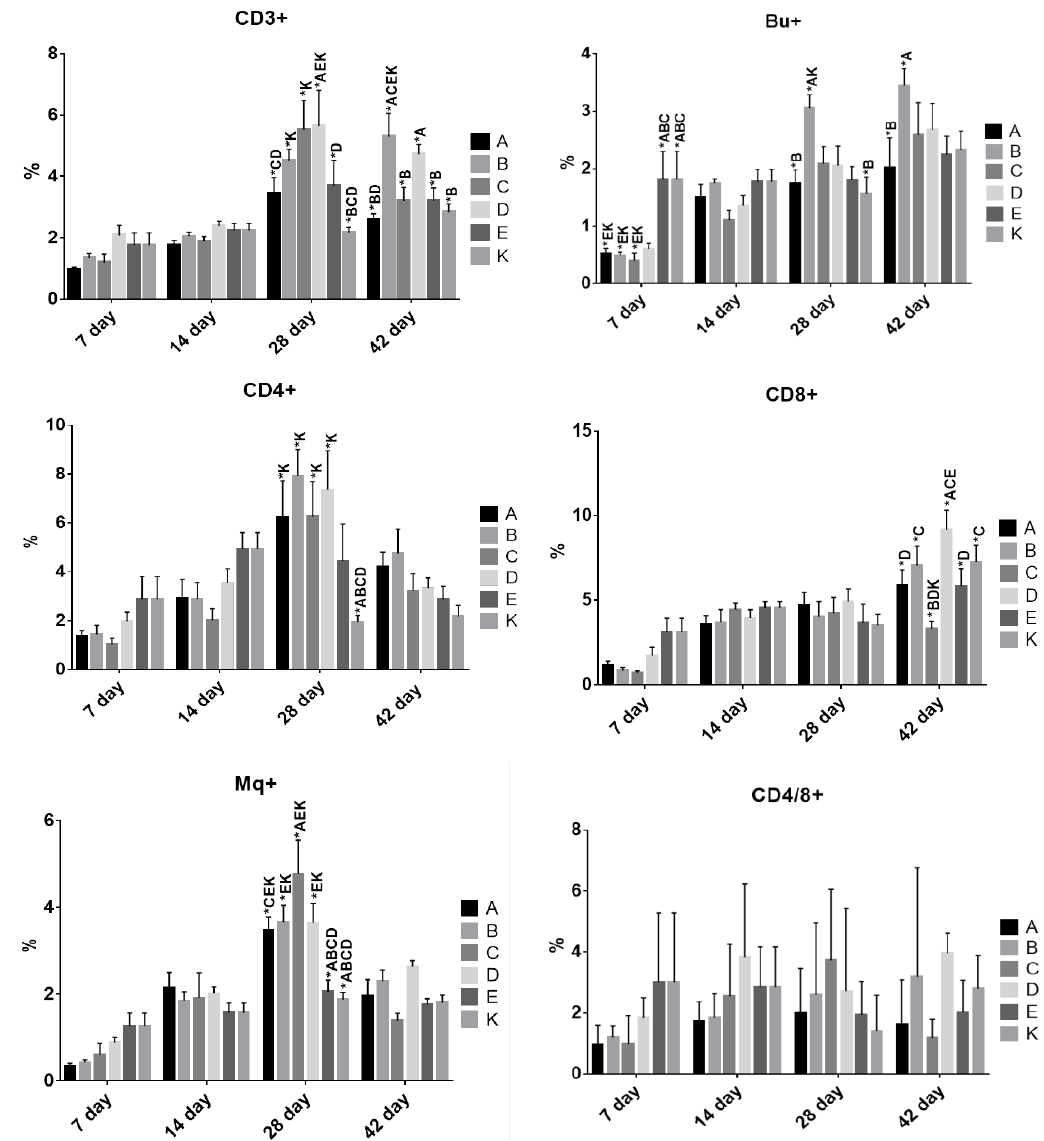
Figure 2. Flow cytometry analysis of the percentage of T lymphocytes with CD3 + , CD4 + , CD8 + , CD4 + /8 + receptors, B lymphocytes (Bu-1 + ) and monocytes (Mq + ) in the blood of the experimental chickens. *—statistically significant differences between groups, p ≤ 0.05.